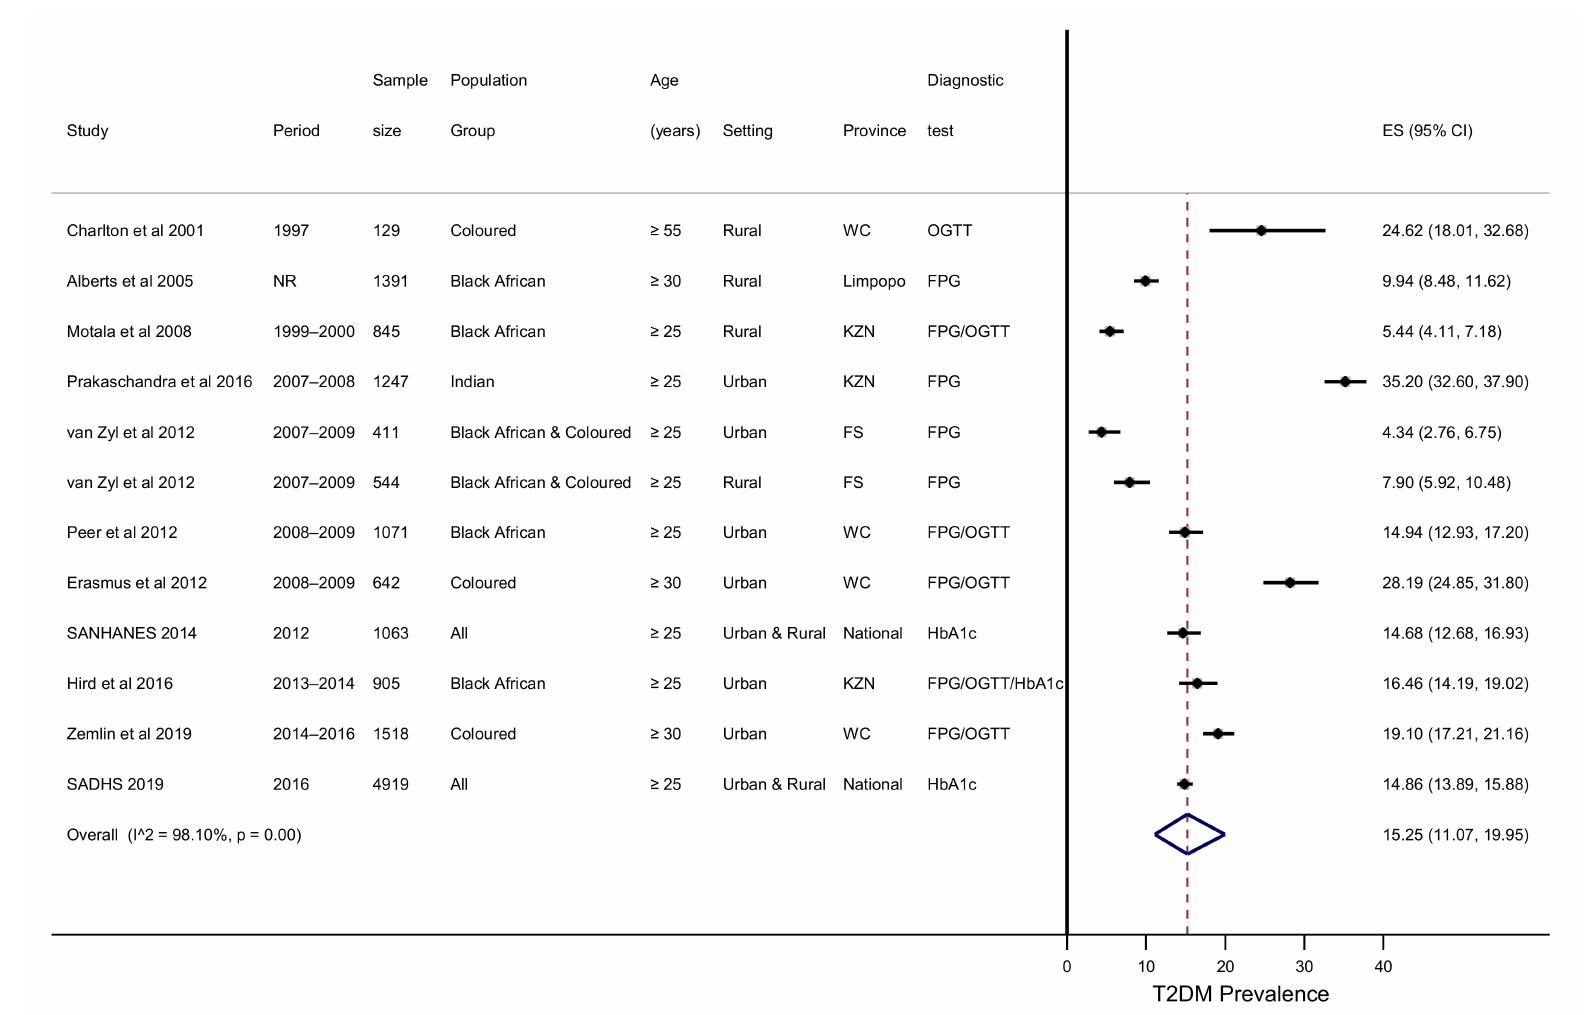
Figure 2. Forest plot of T2DM prevalence. Data are represented as the crude prevalence and 95% CI. EC, Eastern Cape; KZN, KwaZulu Natal; WC, Western Cape. NR, Not